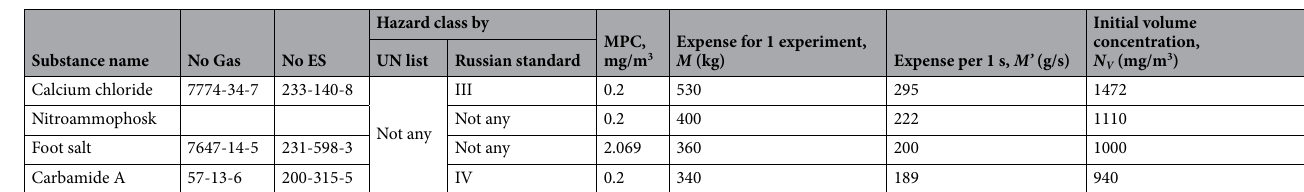
Table 3. Hazard class and consumption of hygroscopic